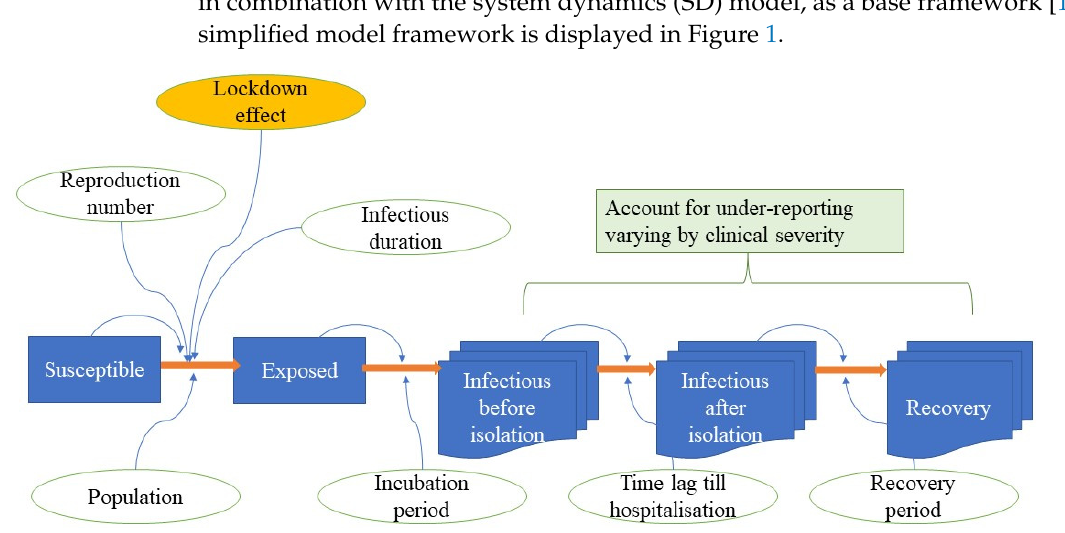
Figure 1. Model Figure 1. Model framework.